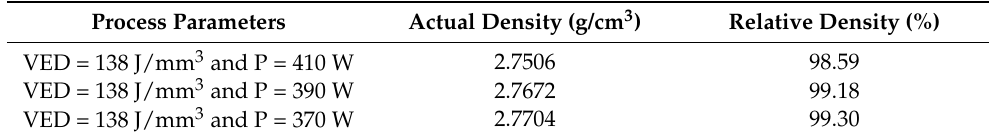
Table 3. Densities of formed